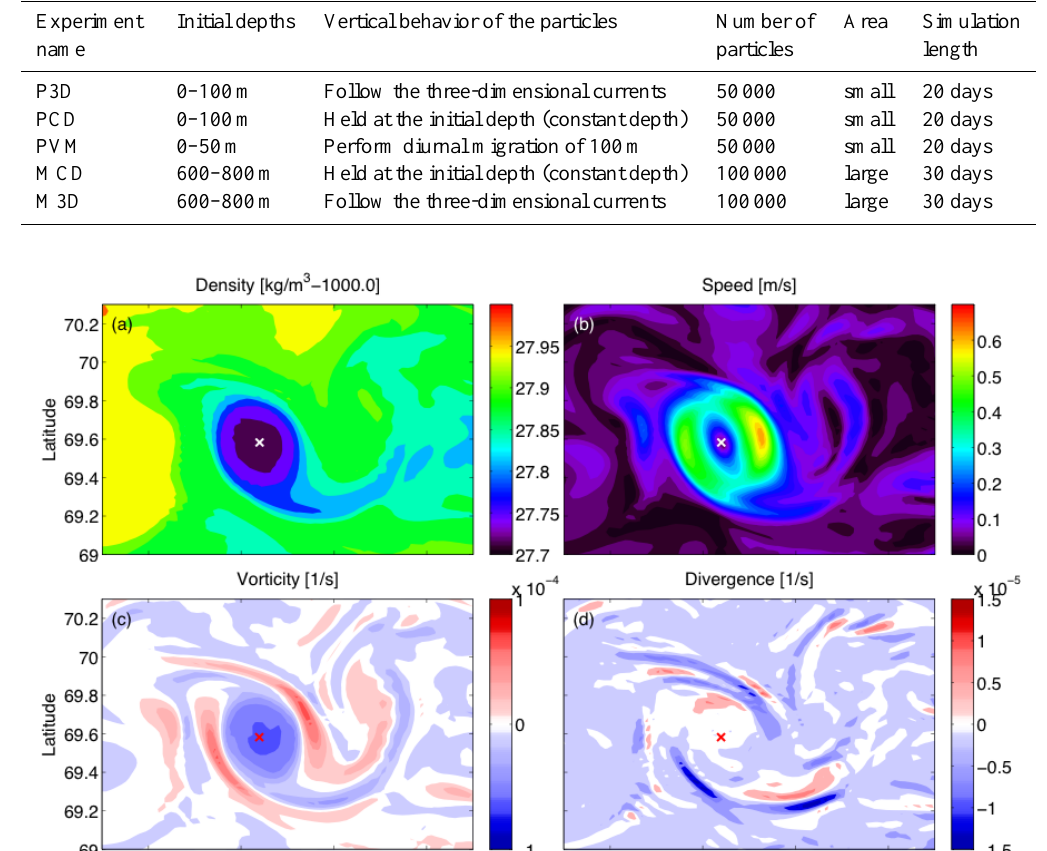
Table 1. Summarizing the 5 different experiments performed with released particles.